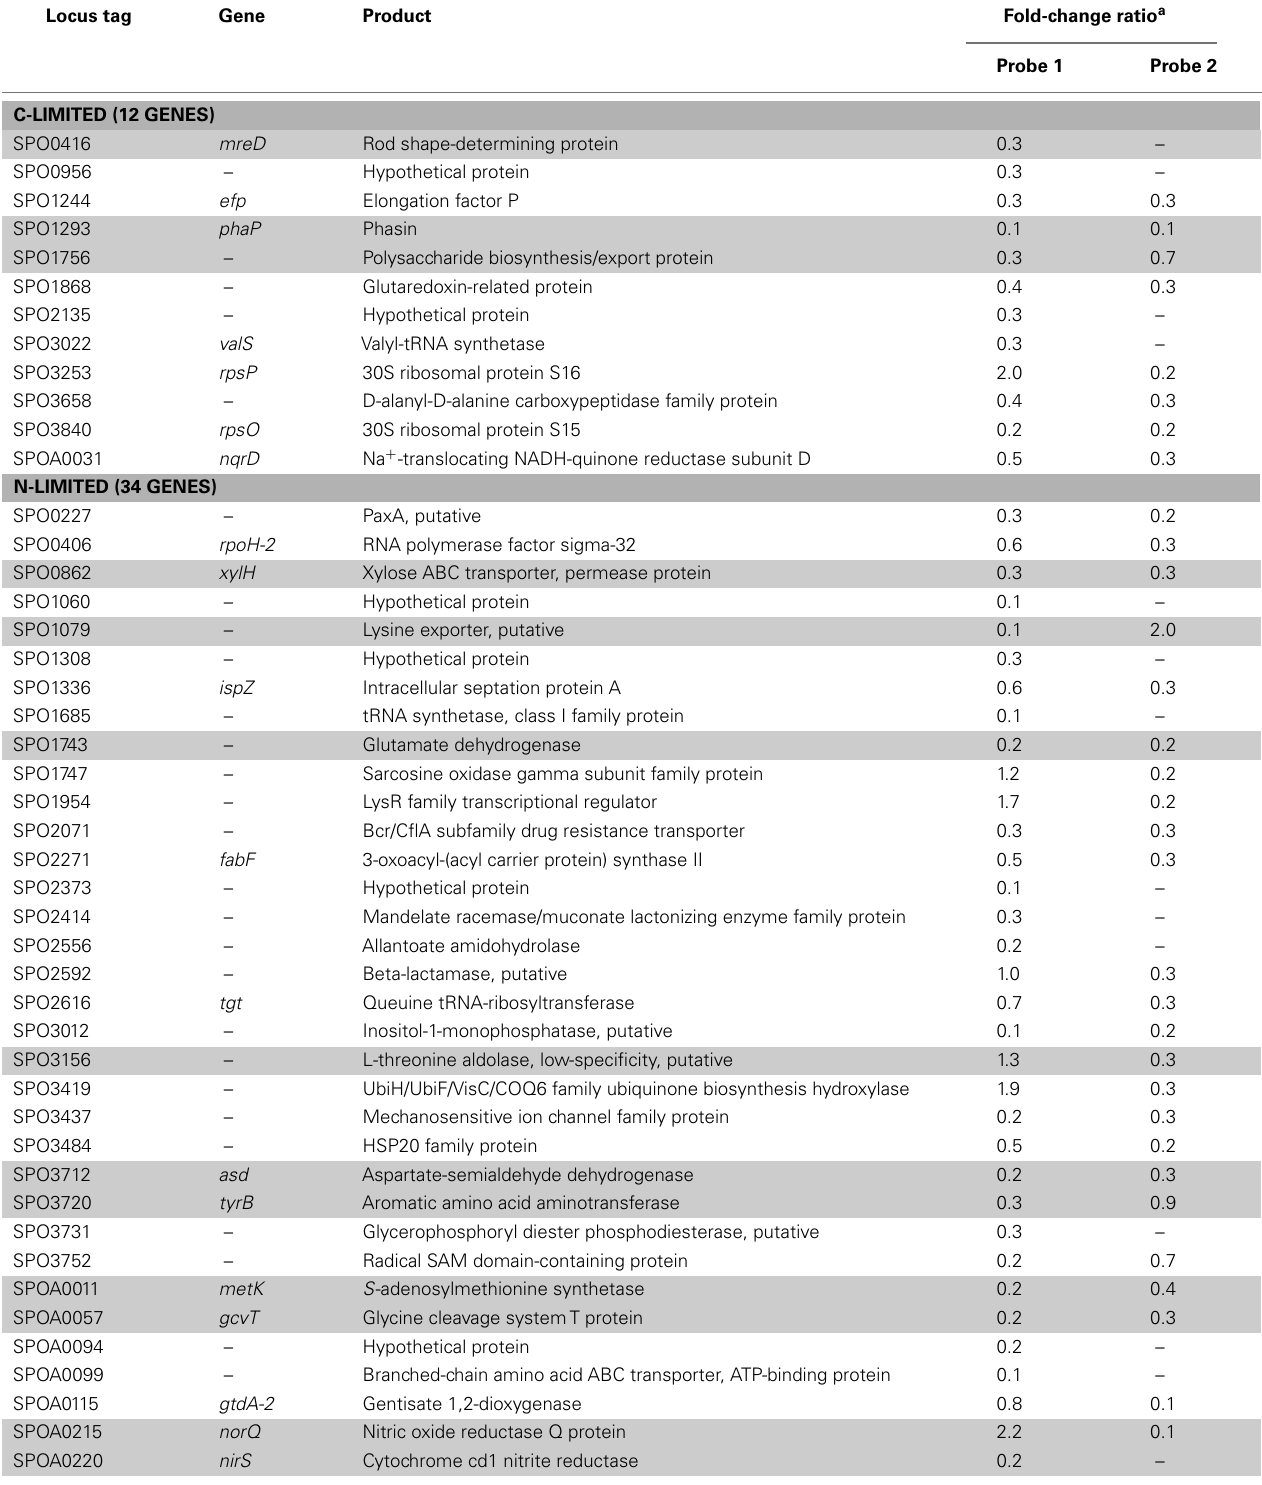
TableA5 |Transcriptionally depleted R. pomeroyi DSS-3 genes. Locus